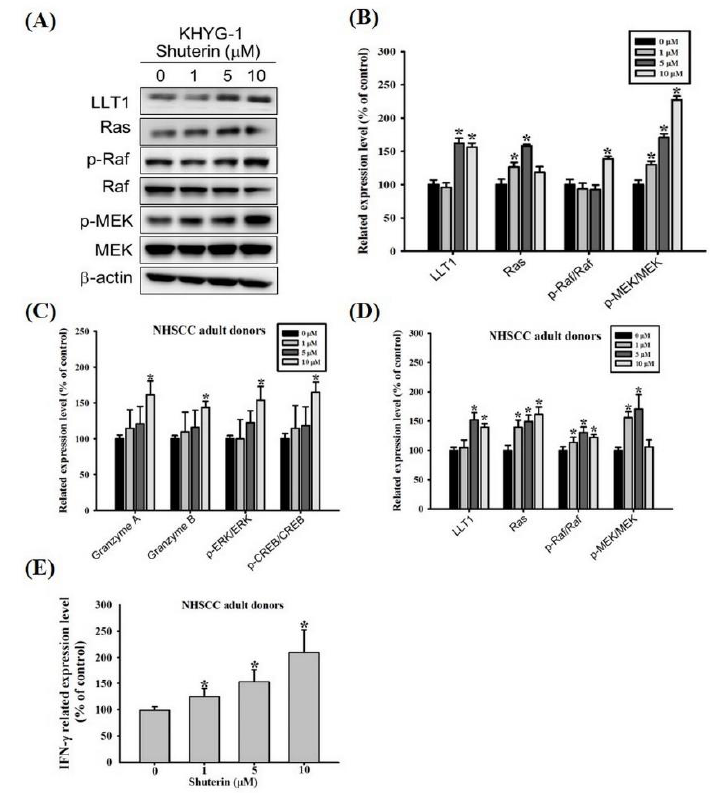
Figure 5. Shuterin induced the Ras/Raf pathway and increased IFN- γ expression in KHYG-1 cells and NK cells obtained from adult patients with head and neck squamous cell carcinoma (HNSCC). Effects of shuterin treatment (24 h) on the proteins involved in the Ras/Raf pathway in ( A , B ) KHYG- 1 cells and ( C , D ) NK cells obtained from adult patients with HNSCC. ImageJ was used for protein quantification; the levels of all proteins were normalized to those of beta-actin. Data are presented as the mean ± standard deviation (n = 3). * p < 0.05 V.S. control. ( E ) Levels of interferon (IFN)- γ in shuterin-treated (24 h) NK cells that were obtained from adult patients with HNSCC (measured through ELISA). 3. Discussion In the present study, shuterin was found to enhance the cytotoxicity of KHYG-1 cells. It exerted considerable cytotoxic effects on K562 cells by enhancing the proliferation of KHYG-1 cells and increasing the expression levels of granzyme A, granzyme B, and IFN- γ . The effect of shuterin on the cytolytic activity of KHYG-1 cells was mediated by the upregulation of the LLT1 receptor and MAPK phosphorylation and the phosphorylation of the proteins involved in the Ras/Raf pathway. Even in NK cells obtained from adult patients with HNSCC, shuterin markedly enhanced cytolytic activity through the same signaling pathway. NK cells account for 10 to 15% of the total human lymphocytes (CD3 − CD56 + cells) [31] and have wide applications in immunotherapy. However, some limitations in their use have been reported. For example, the ability for proliferation and cytotoxic activity is insufficient. Safe strategies must be devised to effectively enhance NK cell proliferation and cytolytic activity [7]. Human permanent NK cell lines are characterized by stable ex- pansion in vitro and maintenance in vitro. KHYG-1 is a cell line that carries a p53 point mutation. Studies have shown that it is more cytotoxic to the K562 cell line than the NK- 92, YT, and SNT-8 cell lines; it also has the same cytotoxic effect to other leukemia cell lines EM2, EM3, and HL60. KHYG-1 cells express NKG2D, the NKp44 receptor, and the adopter DAP12, which can be a model for studying the mechanisms of normal NK cell-